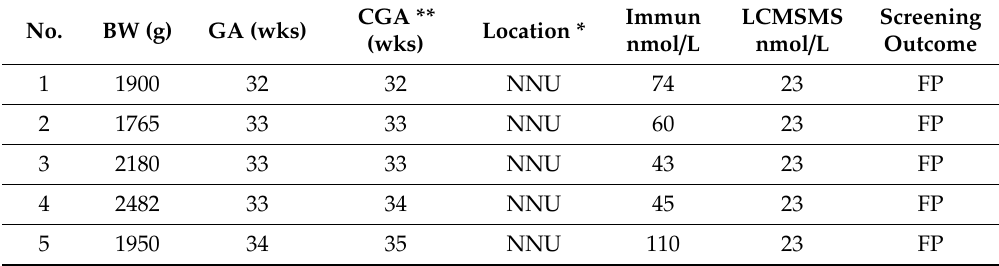
Table A2. Details of all Positive Newborn Screening Specimens Using LCMSMS as a Second Tier Test for Newborn Screening for CAH. *NNU = Neonatal Unit. **CGA = corrected gestational age, FP = false Positive, TP = True